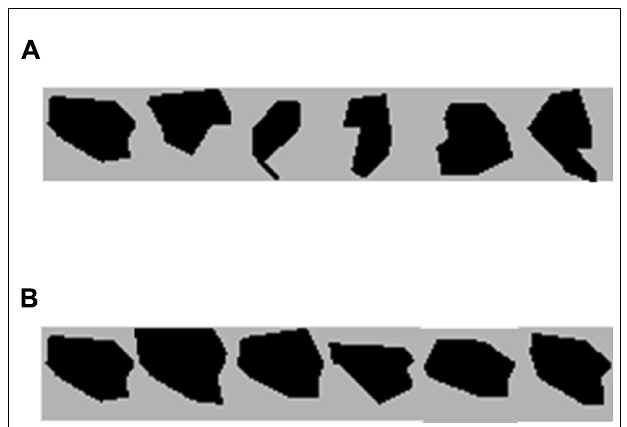
FIGURE 1 | (A) Polygon prototype stimuli used in Experiments 1, 2, and 3. (B) An example of one of the six polygon-sets used in Experiments 1 and 3 with the prototype on the left